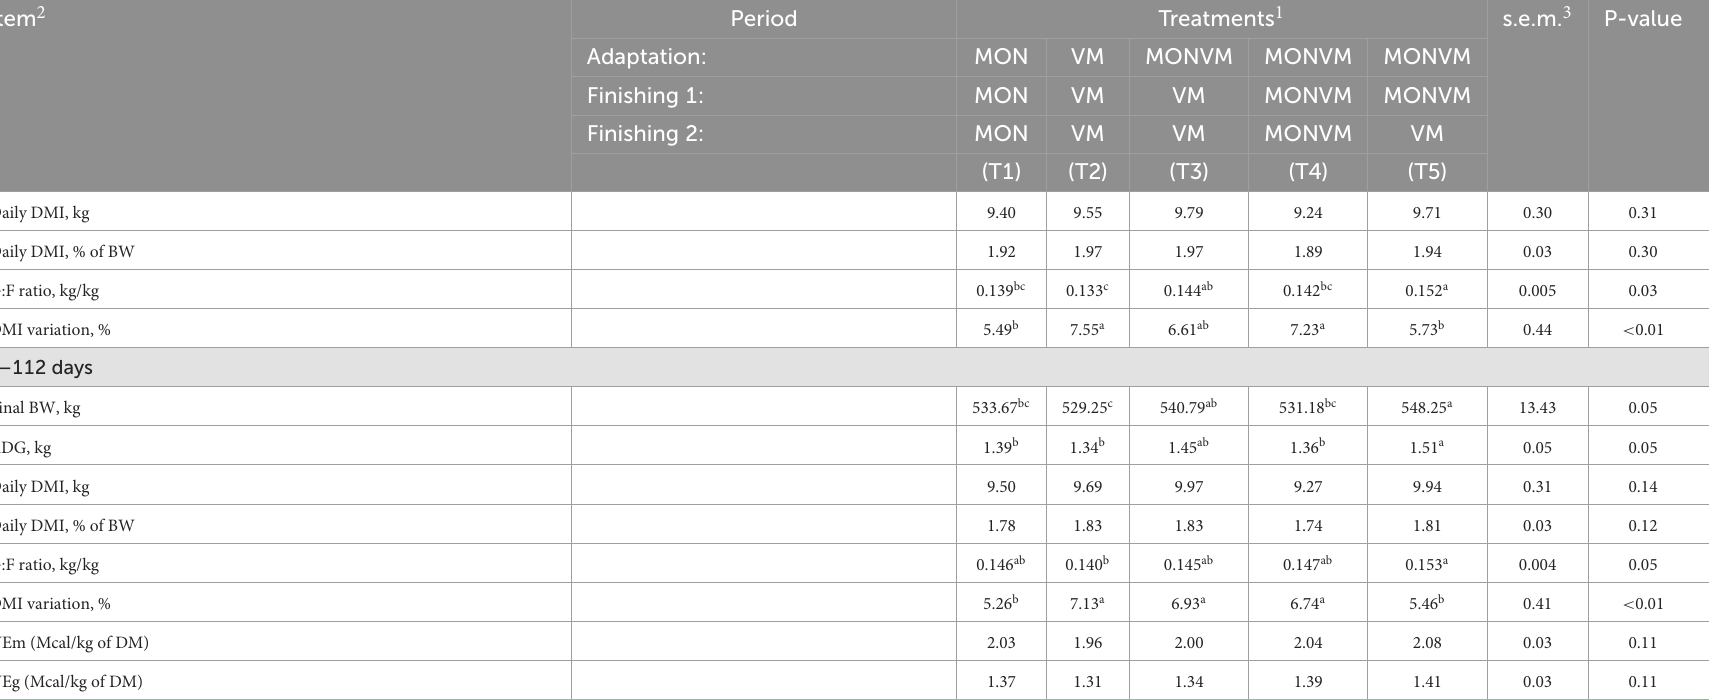
referentto n = 6penspertreatment.Valueswithinarowwithdifferentlowercaselettersdiffer( P <